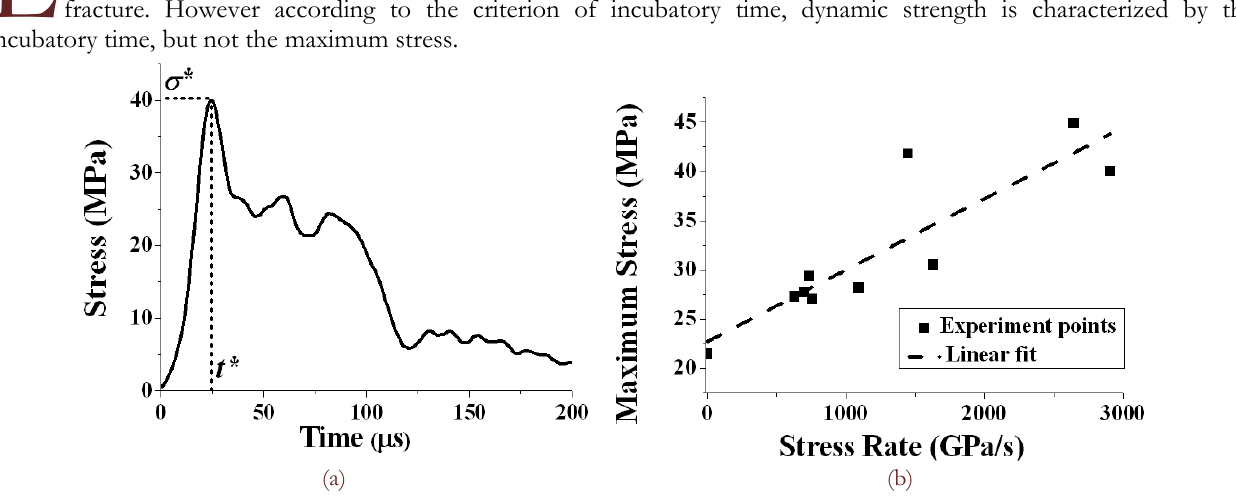
Figure 2: Test results of CARDIFRC in dynamic splitting [2]. a) Typical stress diagram ( σ * is the maximum stress; t* is the fracture time). b) Maximum stress vs stress